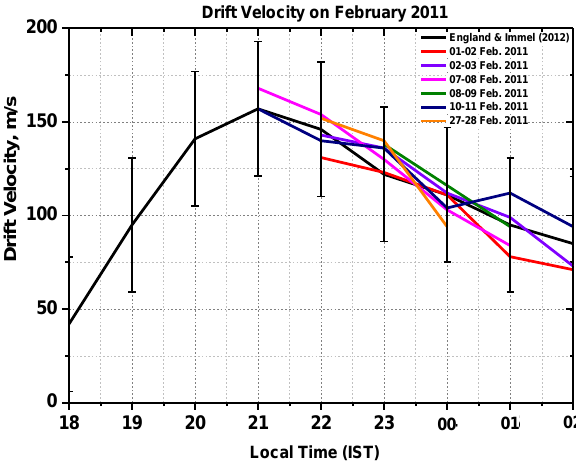
Fig. 4. The daily mean zonal drift velocities of EPBs compared with values of the empirical model for the period of February 2011.